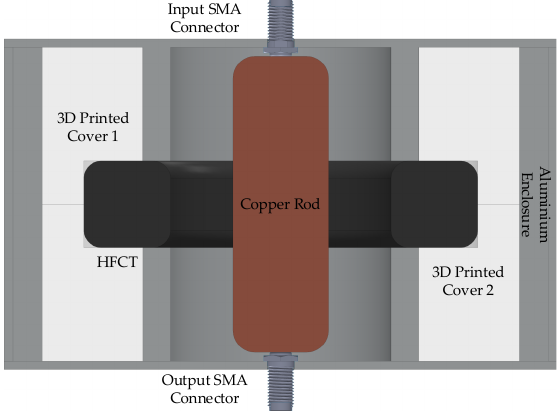
Figure 5. HFCT enclosure configuration.